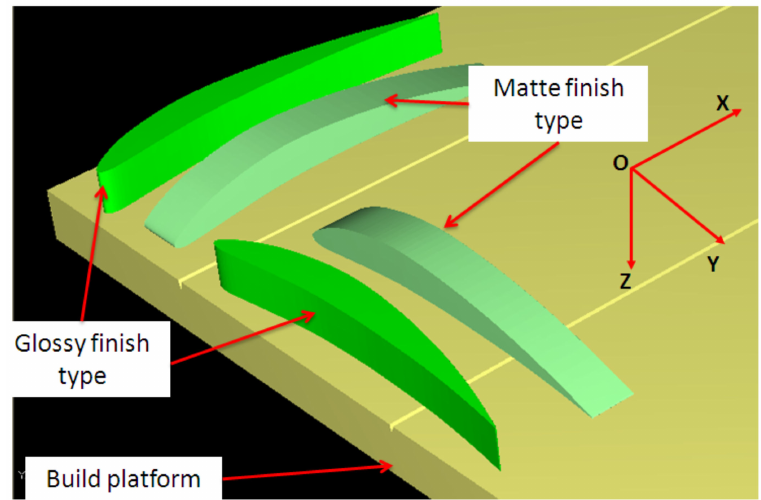
Figure 5. XY and YX orientations of the airfoil artifact. The first symbol indicates the longitudinal direction on the printing table and the second one indicates the transverse